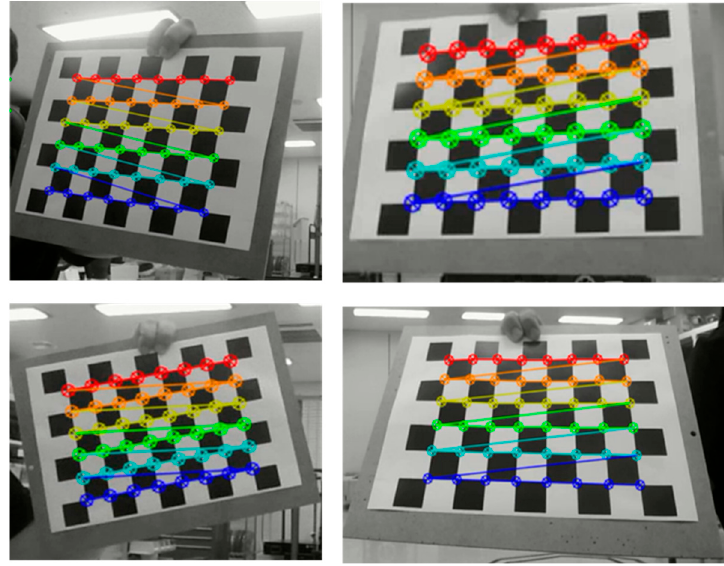
Figure 7. Checkerboard images for camera calibration.